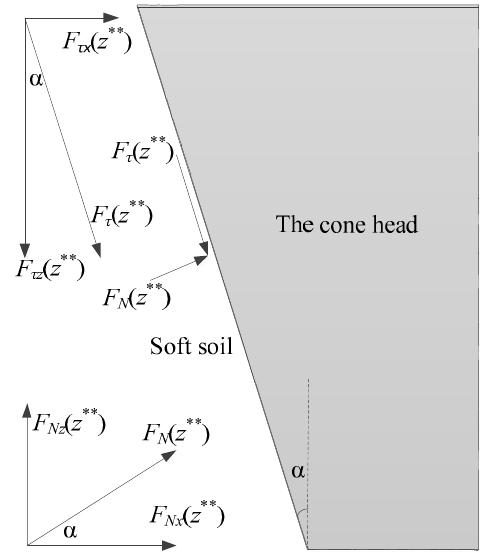
Figure 5. Interaction between the conical head and the soil.